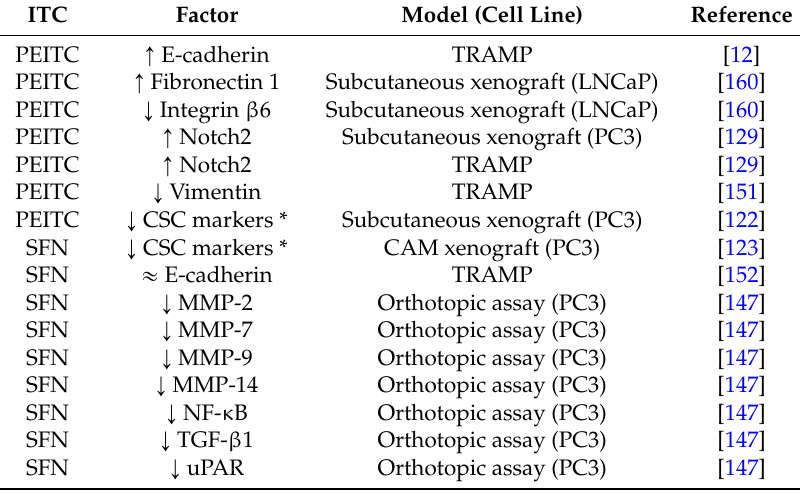
Table 8. ITCs inhibit the in vivo and ex vivo growth of prostate tumors by inhibiting invasion and